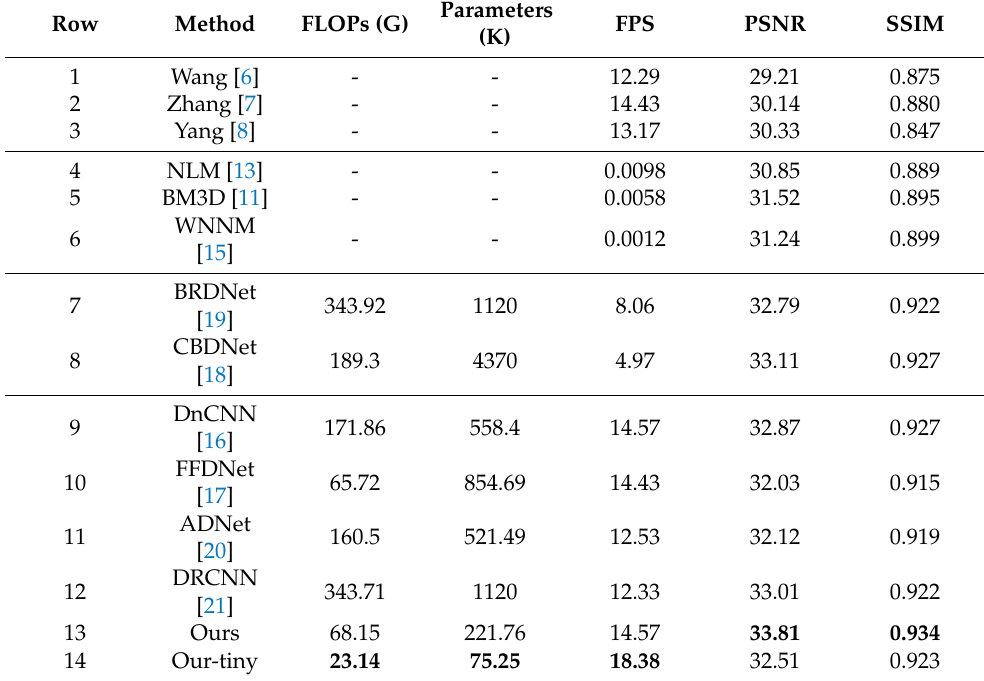
Table 1. Quantitative results of denoising methods on nuclear radiation dataset. In each column, compared with all methods, the best value is marked in